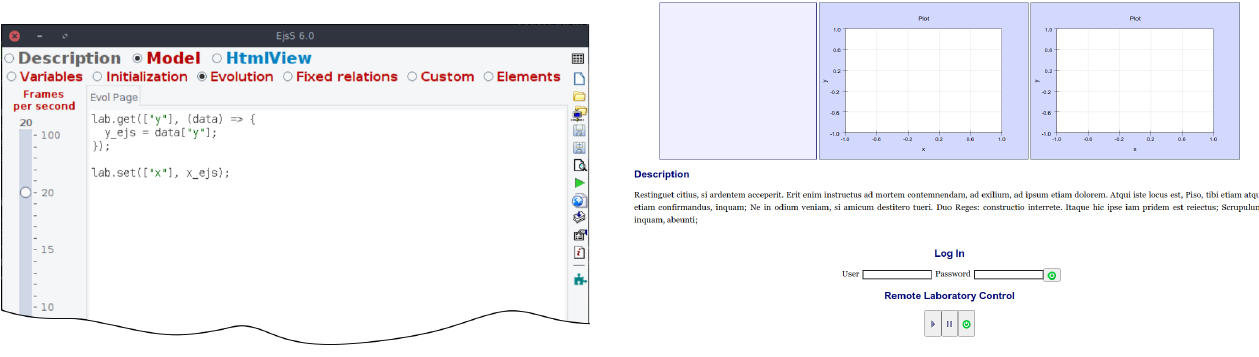
Figure 11. How to set up the Lab from